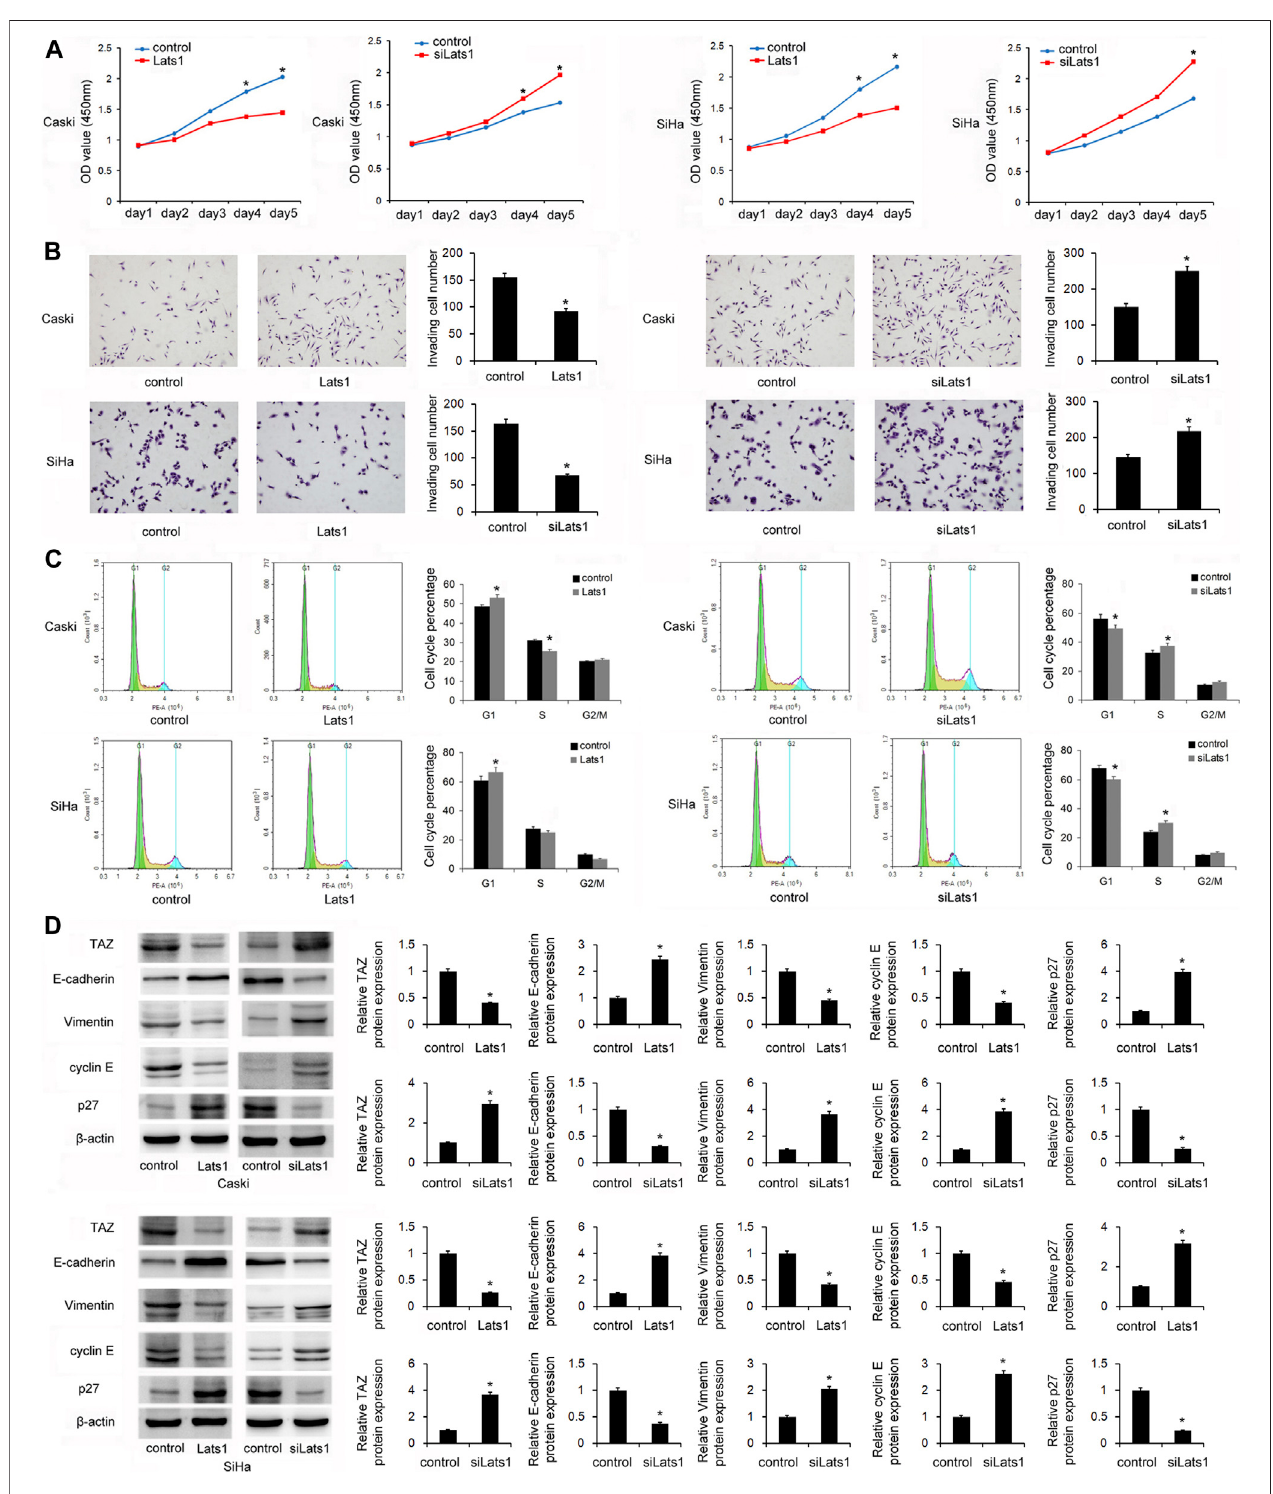
FIGURE 4 | LATS1 inhibited proliferation, invasion, and the cell cycle in cervical cancer stem cells. (A) The Cell Counting Kit-8 assay showed that LATS1 overerxpression inhibited cell growth in SiHa and Caski cells. Large tumor suppressor 1 (LATS1) siRNA increased the cell growth in SiHa and Caski cells. (B) The Transwell invasion assay showed that LATS1 overexpression decreased invading cell numbers while LATS1 siRNA knockdown increased invading cell numbers (C) FlowcytometryshowedthatLATS1overexpressionincreasedtheG1phasepercentageanddecreasedtheSphasepercentage.LATS1siRNAdecreasedtheG1 percentage and upregulated the S phase percentage. (D) Western blotting results showed that LATS1 overexpression downregulated TAZ, vimentin, cyclin E, and upregulated E-cadherin and p27 protein levels in SiHa and Caski cells. LATS1 silencing upregulated TAZ, vimentin, cyclin E, and downregulated E-cadherin and p27 levels in SiHa and Caski cells. * p <